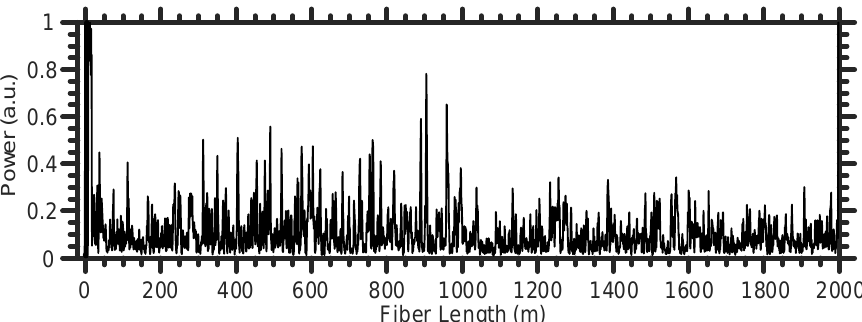
Figure 3. A representative example of a Rayleigh trace recorded by the fiber optic